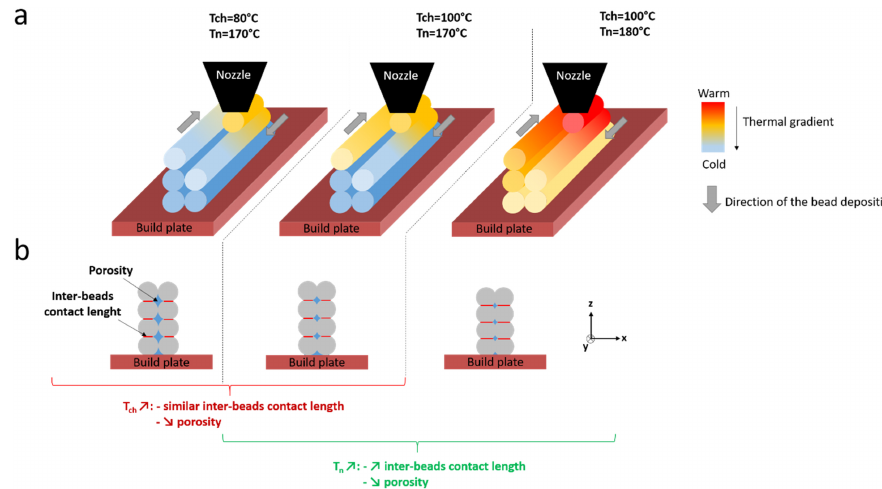
Figure 4. A schematic outline of the influence the chamber temperature T ch and nozzle temperature T n have on the consolidation of deposited iPP filaments, i.e., beads, through FFF ( a ) along the deposited filament and ( b ) along the cross-section in the ZX-plane. Here, a higher chamber temperature lowers the porosity, described as the gap between deposited filaments, and a higher nozzle temperature increases the length between two deposited filaments and decreases the porosity. Reproduced with permission [83], Copyright 2021,